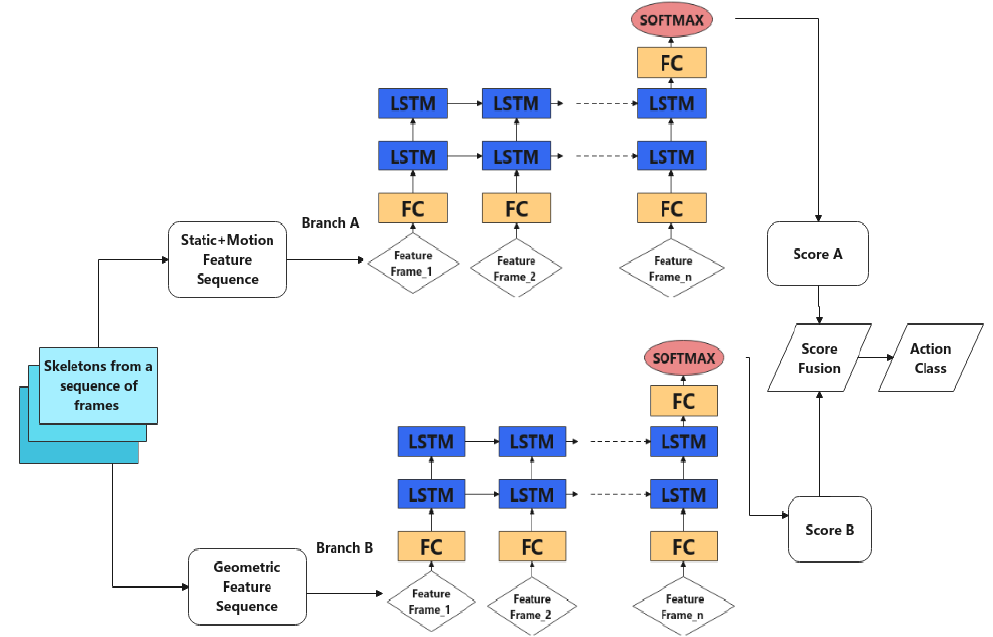
Figure 3. Network structure of proposed action recognition